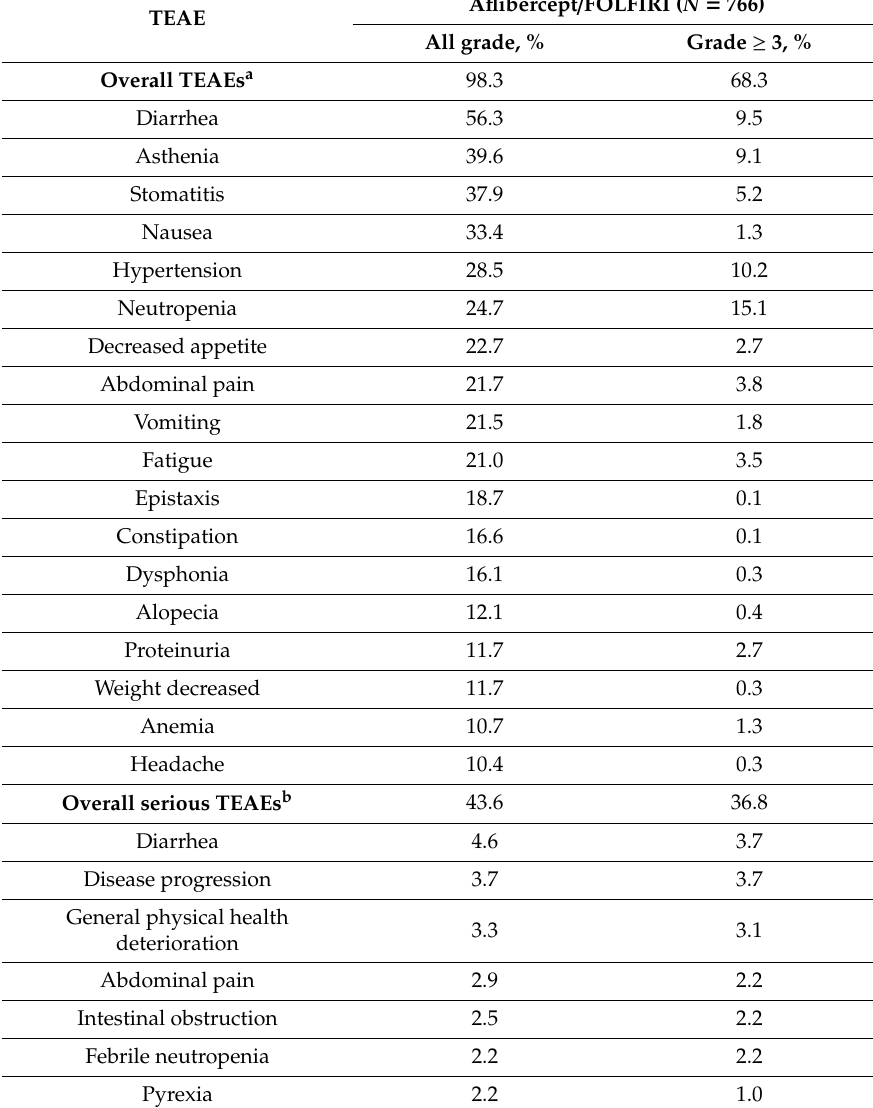
Table 4. Summary of treatment-emergent adverse events: overall